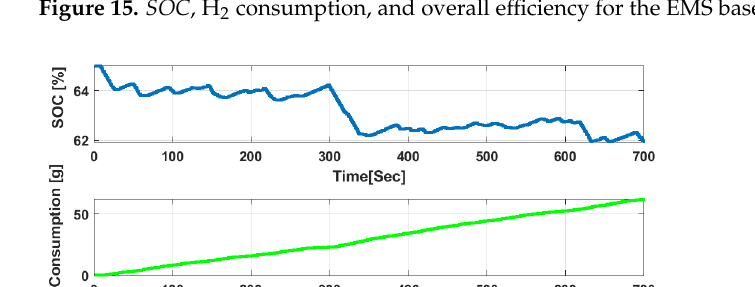
Figure 15. SOC , H 2 consumption, and overall efficiency for the EMS based on SMC.